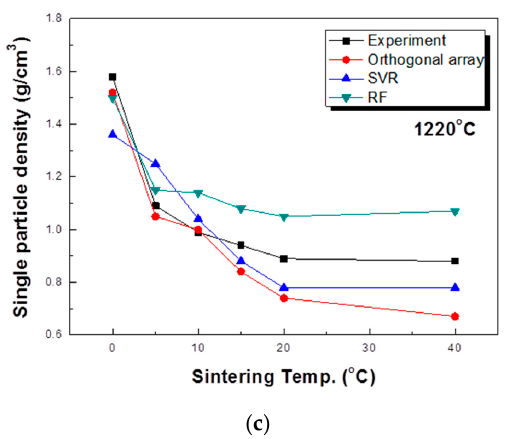
Figure 7. Prediction of the single particle density according to each analysis method: ( a ) 1180 °C , ( b ) 1200 °C , and ( c ) 1220 °C .